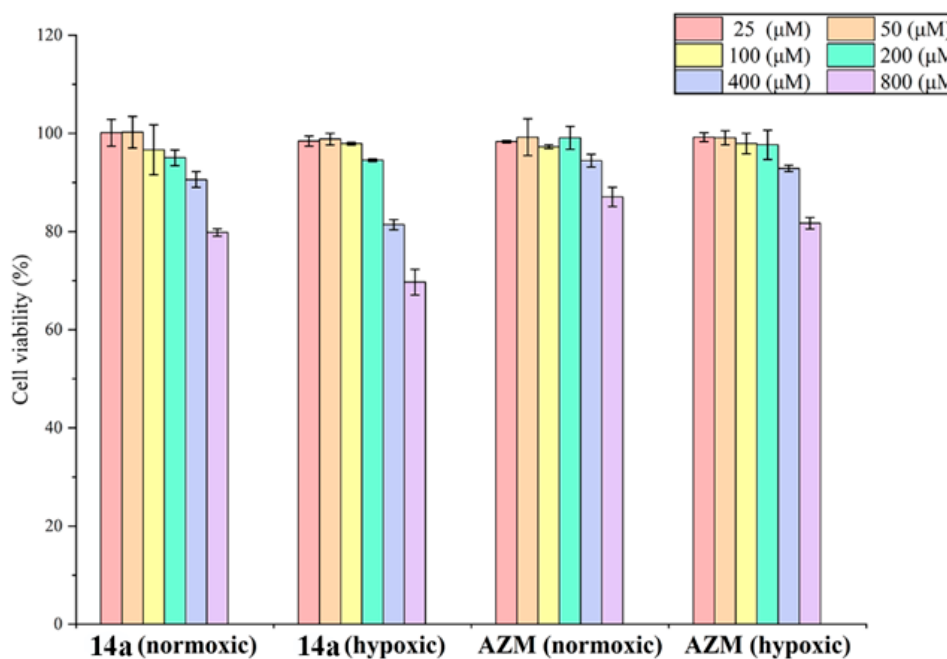
Figure 6. Effects of compounds 14a and AZM on the cell viability of MG-63 under normoxic and hypoxic conditions.